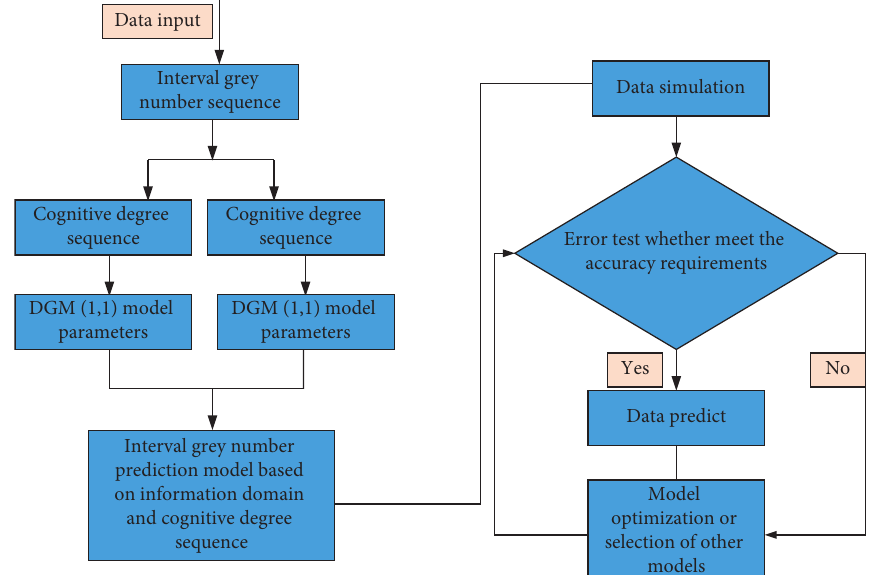
Figure 2: Interval grey number sequence